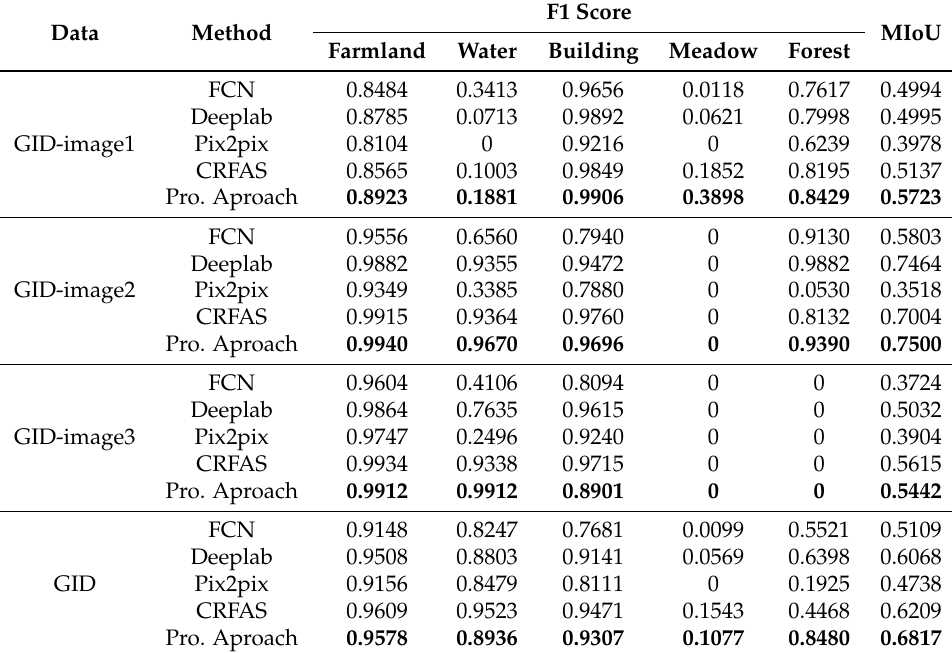
Table 7. F1 score and MIoU of